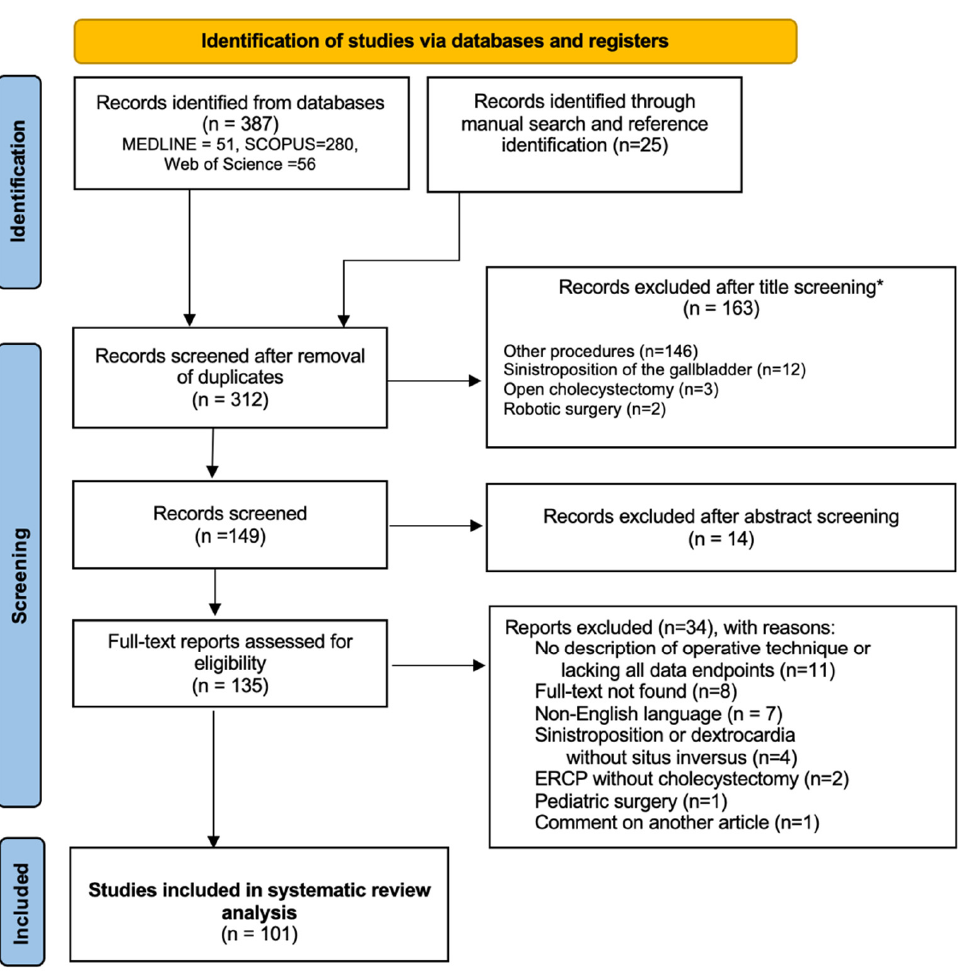
Figure 1. PRISMA flow diagram for research results. * all items excluded manually